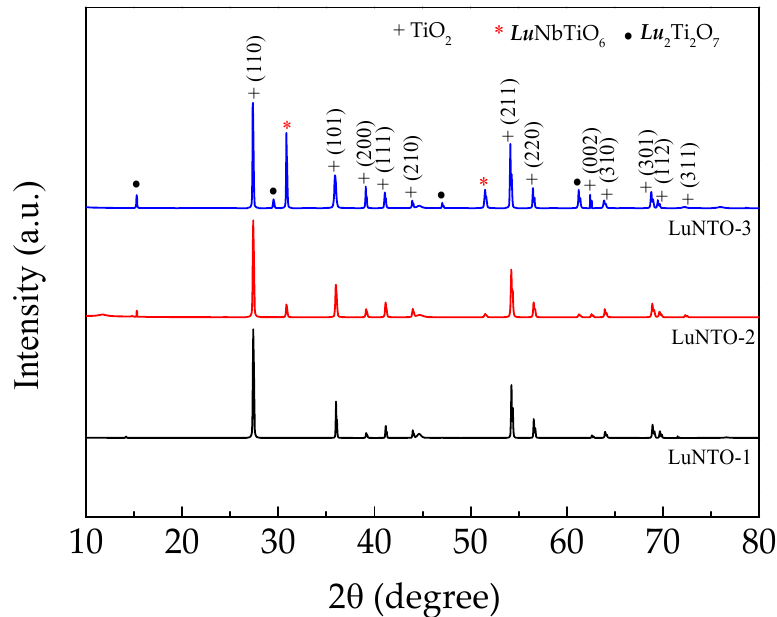
Figure 1. XRD patterns of the LuNTO ceramics. Table 1. Dielectric properties at 1 kHz and 25 °C, lattice parameters, and mean grain sizes.